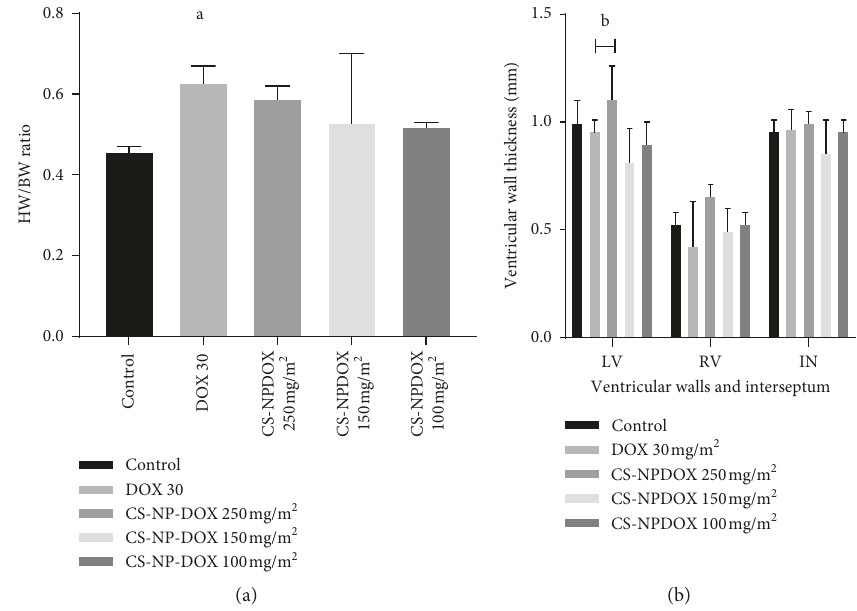
Figure 7: Morphometric assessment of the heart. (a) Mean heart weight-to-body weight ratio. (b) Mean ventricular wall thickness (mm) of dogs given normal saline, cumulative dose of free doxorubicin 150mg/m 2 , CS-CaCO 3 NP-DOX 250mg/m 2 , CS-CaCO 3 NP-DOX 3). p 0 . 05 is considered statistically significant between the groups. 150mg/m 2 , and CS-CaCO 3 NP-DOX 100mg/m 2 ( n (cid:31) <